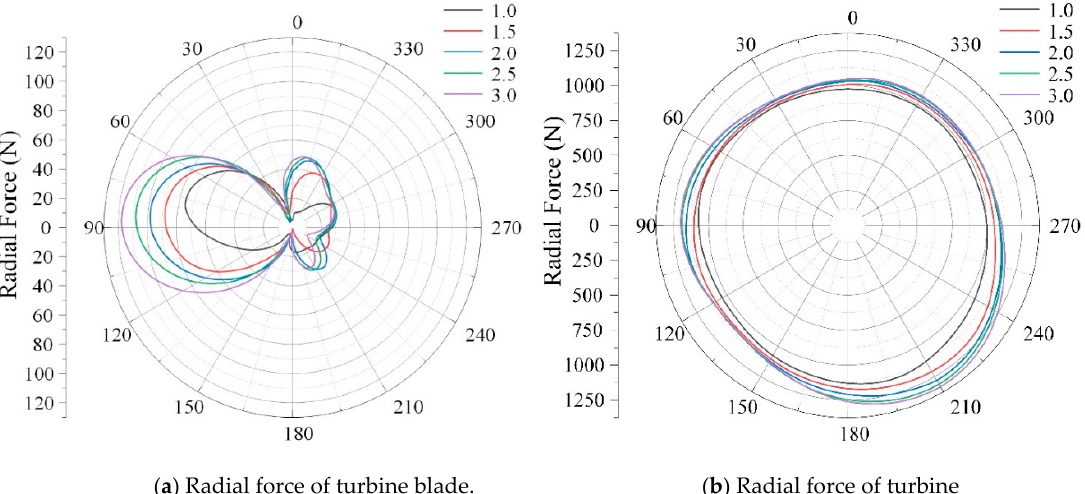
Figure 16. Radial force of turbine and blade in different λ . ( a ) Radial force of turbine blade. ( b ) Radial force of turbine.